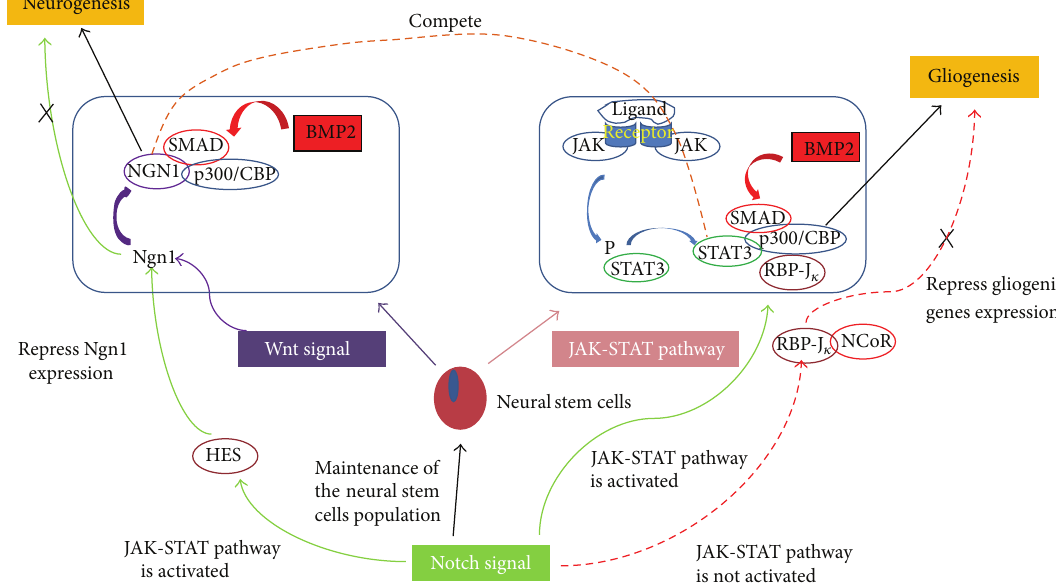
Figure 4: Crosstalk between Wnt, Notch, and JAK-STAT signaling pathways. Wnt signaling activates Ngn1, which then binds p300/CBP coactivator proteins to promote neuronal differentiation. Ngn1 competes with STAT3 to inhibit gliogenesis during neurogenic phases. During gliogenesis, the STAT3 transcription factor is activated through phosphorylation by JAKs. The active form of STAT3 binds the p300/CBP coactivatorproteinsandpromotesgliogenesis.Notchsignalingactivatesgliogenicgenes;HESinhibitsneurogenesisviainhibitionofproneural genes. At the same time, RBP-J 𝜅 is also activated to promote gliogenesis. RBP-J 𝜅 binds a repressive cofactor protein, termed nuclear receptor corepressor, to suppress gliogenic genes and inhibit glial cell differentiation when the JAK-STAT pathway is not